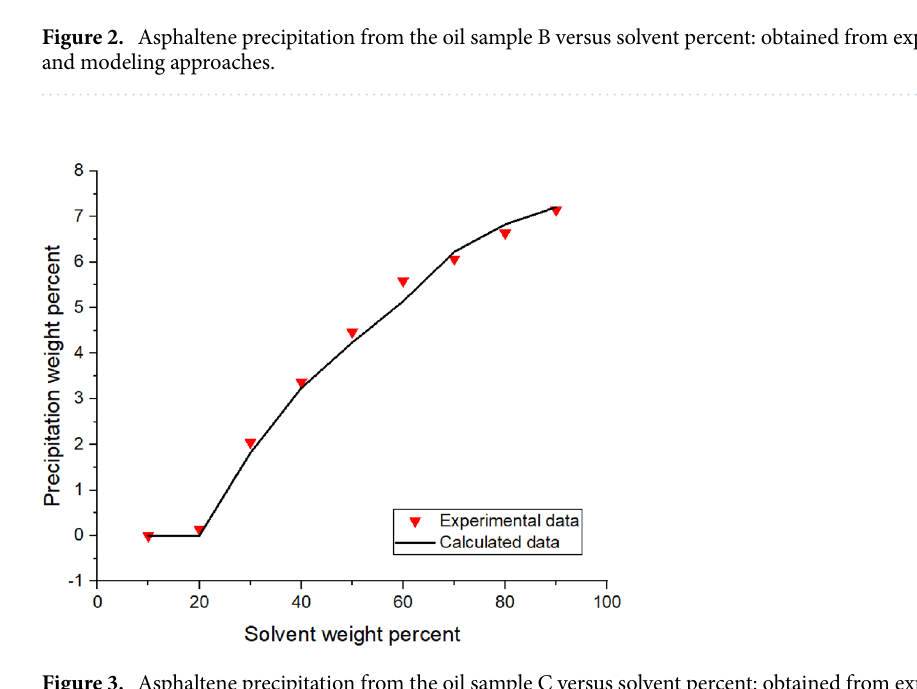
Figure 3. Asphaltene precipitation from the oil sample C versus solvent percent: obtained from experimental and modeling approaches.